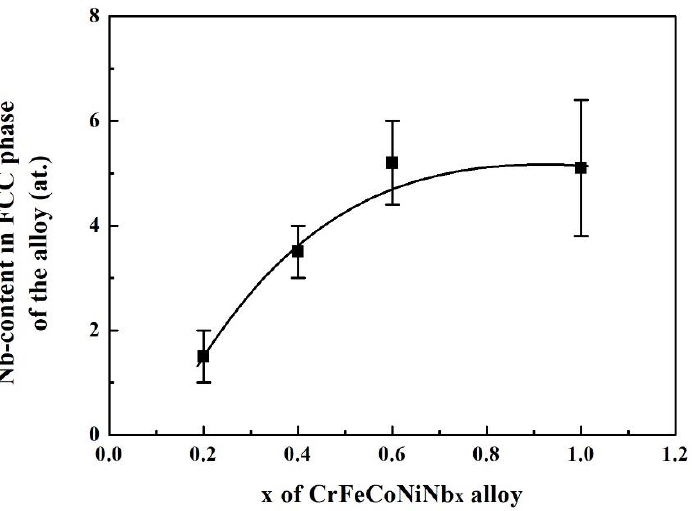
Figure 2. Plot of Nb content in FCC phase of a CrFeCoNiNb x alloy as a function of Nb content [15,18].